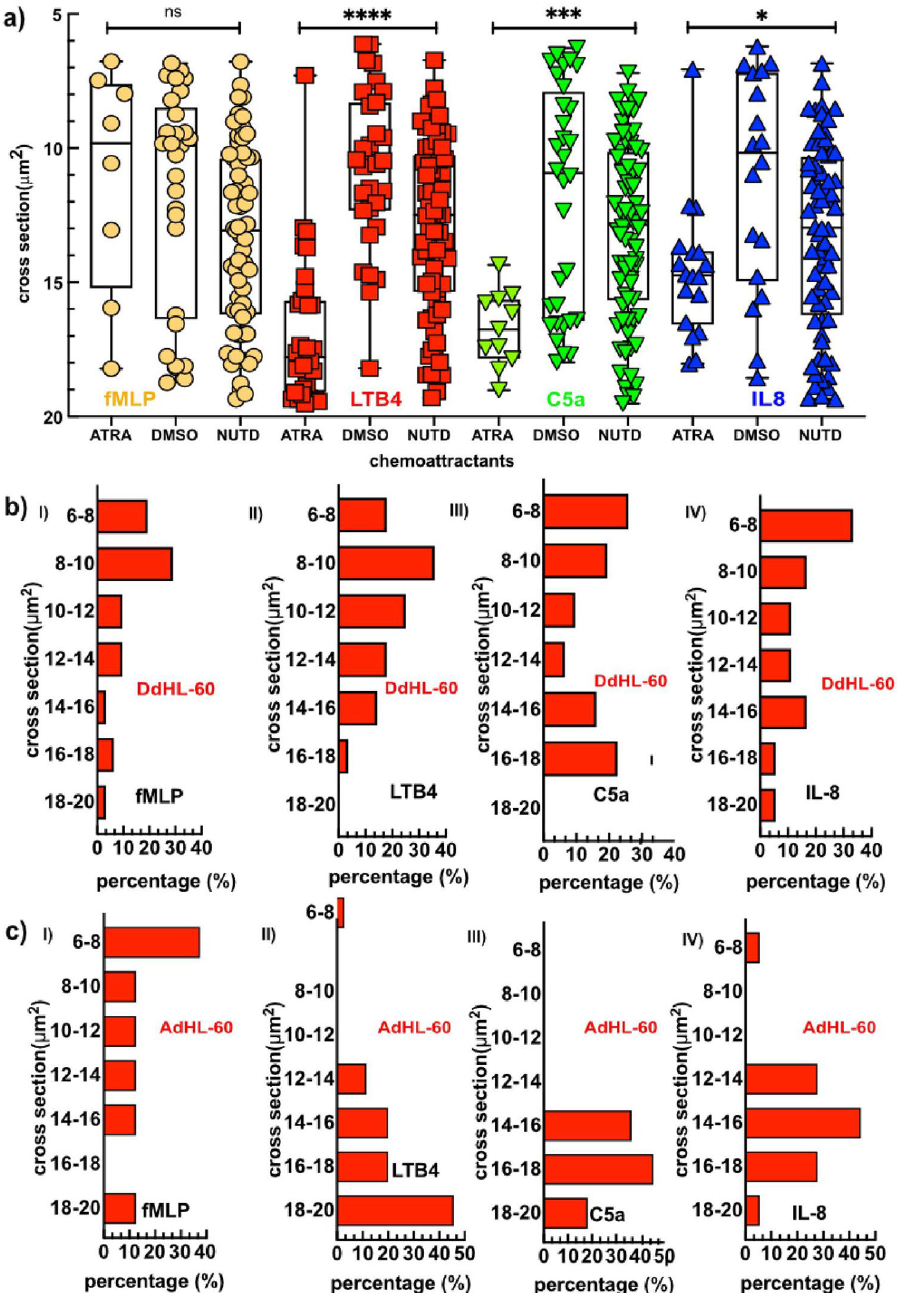
Figure 3. The differentiation protocol alters the ability of HL-60 cells to traverse narrow strictures. ( a ) Critical cross section where Arrest, Oscillation and Retrotaxis occur in ( a ) AdHL-60 (ATRA), ( b ) DdHL-60 (DMSO) and ( c ) nDdHL-60 (NUTD) in tapered straight channel in chemokine gradients of fMLP (Orange), LTB4 (Red), C5a (Green) and IL-8 (Blue). Histograms of Arrest, Oscillation and Retrotaxis critical sections in ( d ) DdHL-60 cells and ( e ) AdHL-60 in different chemokine gradients. Comparison between the number of cells in the different critical cross section toward each chemo-attractants were performed by one-way ANOVA; **** P < 0.0001 in LTB4, *** P < 0.001 in C5a and * P < 0.05 in